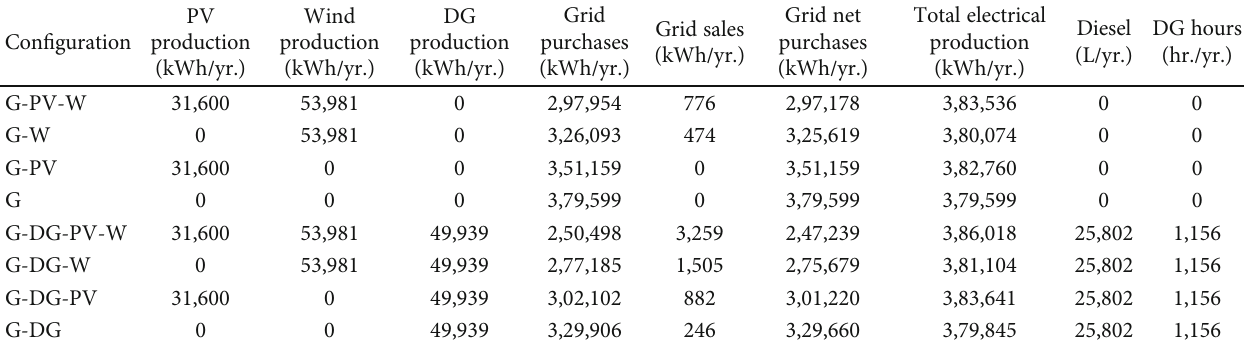
Table 4: HOMER optimization result for energy